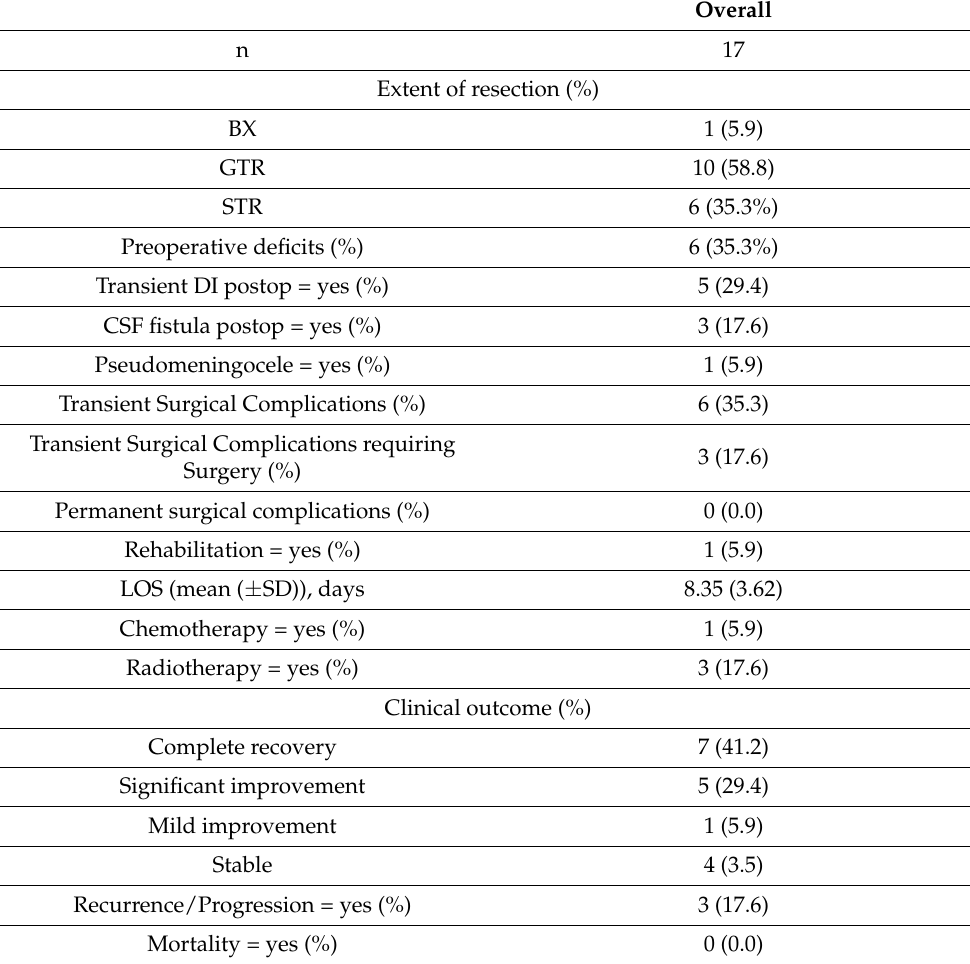
Table 2. Overall surgical